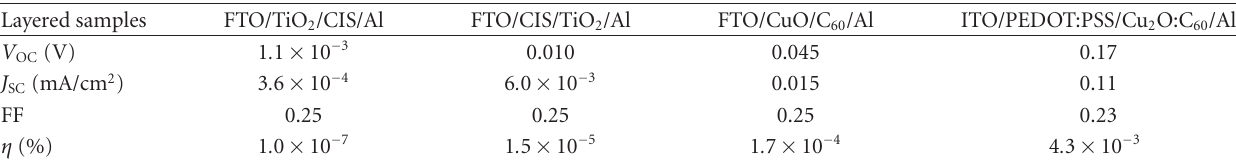
Table 1: Measured parameters of solar